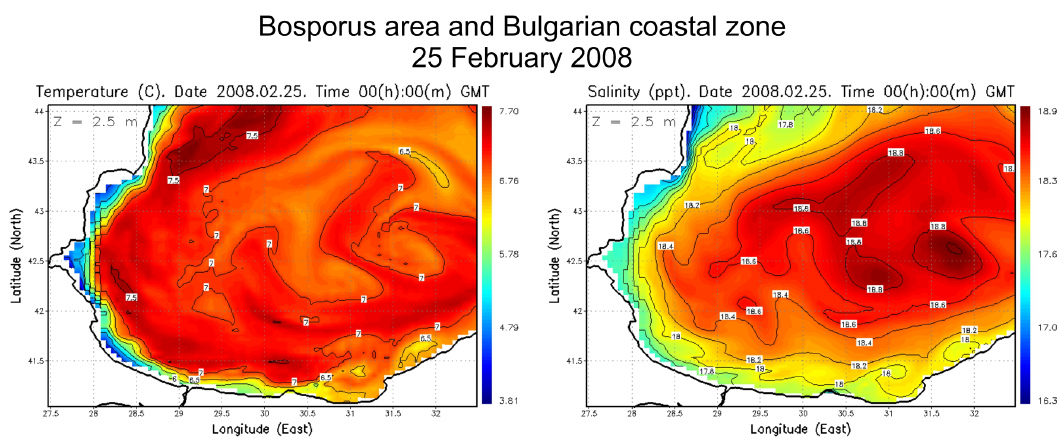
Fig. 5. SST (left) and surface salinity (right) analysis in the region near the Bosphorus Strait and Bulgarian coast (area BB) on 25 February 2008.